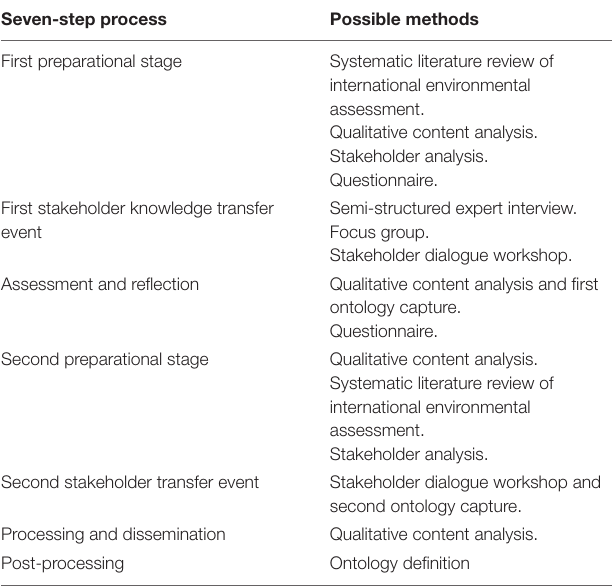
TABLE 1 | Seven-step process and methods applied in INTERNAS knowledge